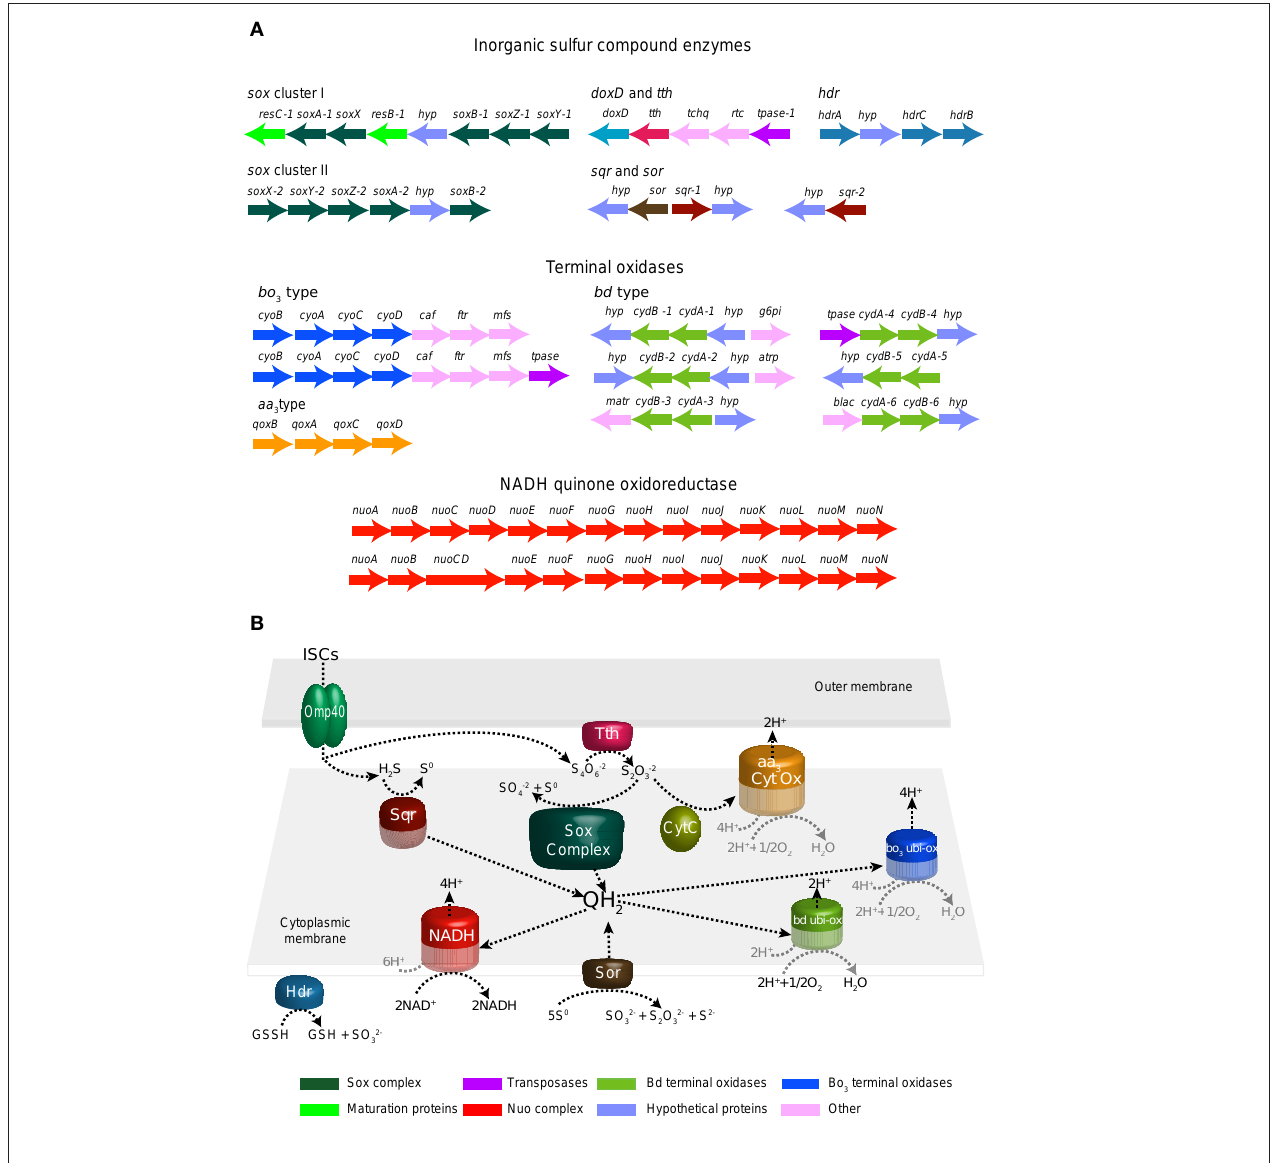
reductase; sor , sulfur oxygenase reductase; hyp , hypothetical protein; caf , cytochrome oxidase assembly factor; ftr , heme O synthase, protoheme IX farnesyltranferase; g6pi , glucose 6-p isomerase; mfs , major facilitator superfamily protein; atrp , putative amino acid transporter; matr , putative malic acid transporter; blac , beta lactamase; tpase , transposase; tchq , two component system – histidine quinase; rtc , two component system – response